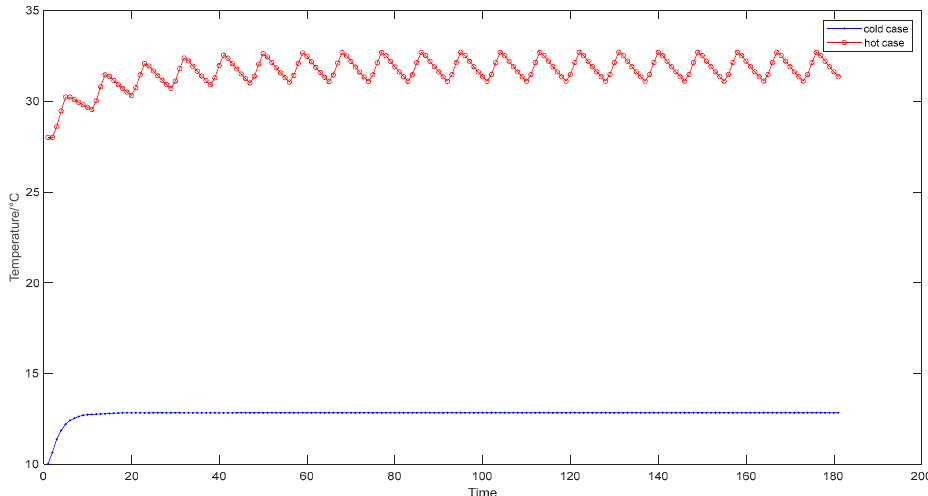
Figure 13. CMOS temperature fluctuations in the high- and low-temperature cases.